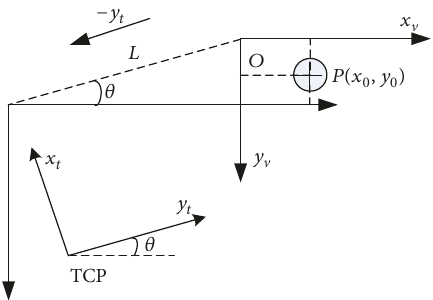
Figure 4: Direction calibration of industrial